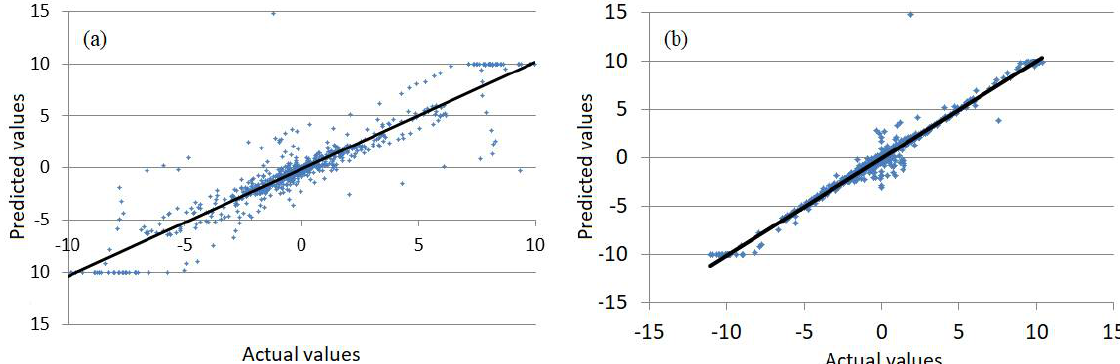
Figure 10. Computed values (Predicted) versus the recorded ones (Actual) in ( a ) the Wavelet-ARIMA model) and ( b ) the Wavelet-ANN model (output from the R software).